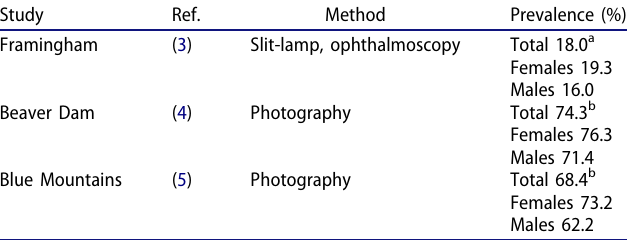
Table 1. Prevalence of cataract in subjects 65 – 74years of age in the Framingham Eye Study, the Beaver Dam Eye Study, and the Blue Mountains Eye Study. Study Ref.